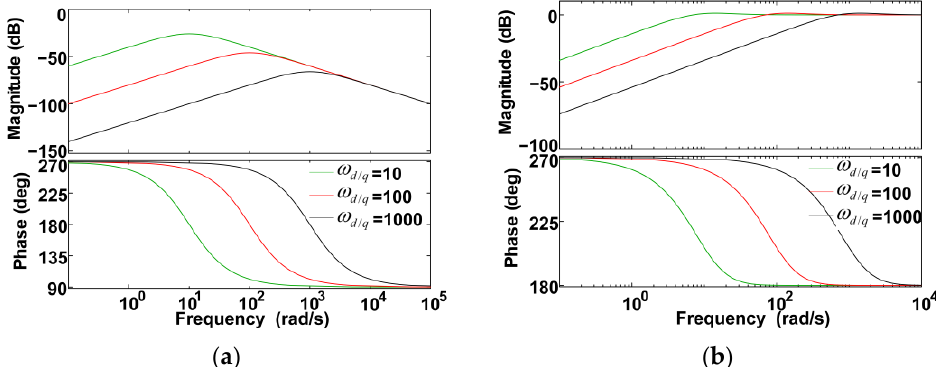
( s ) ; ( b ) G e ( s ) d 1/ q 1 d 2/ q 2